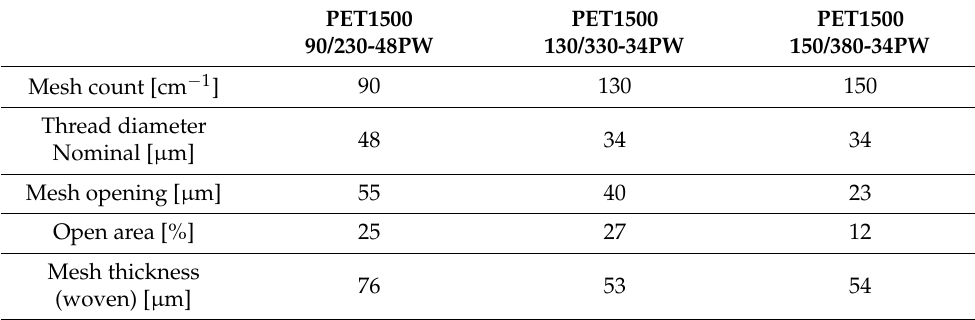
Table A2. SEFAR ® PET 1500 description.